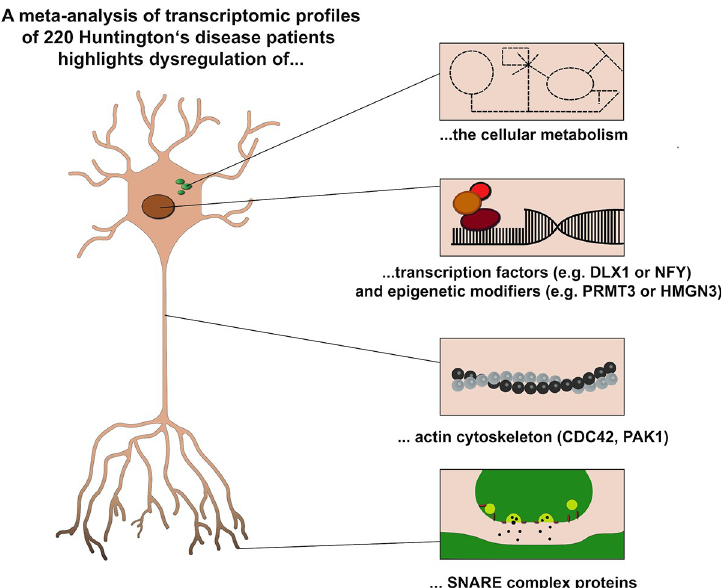
Fig 9. Schematic illustration of transcriptomic alterations in the brain of HD